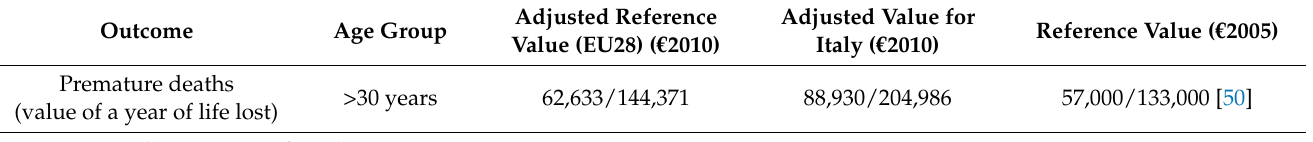
Table 4. Cost values considered in the economic health impact assessment (price year 2010). Outcome